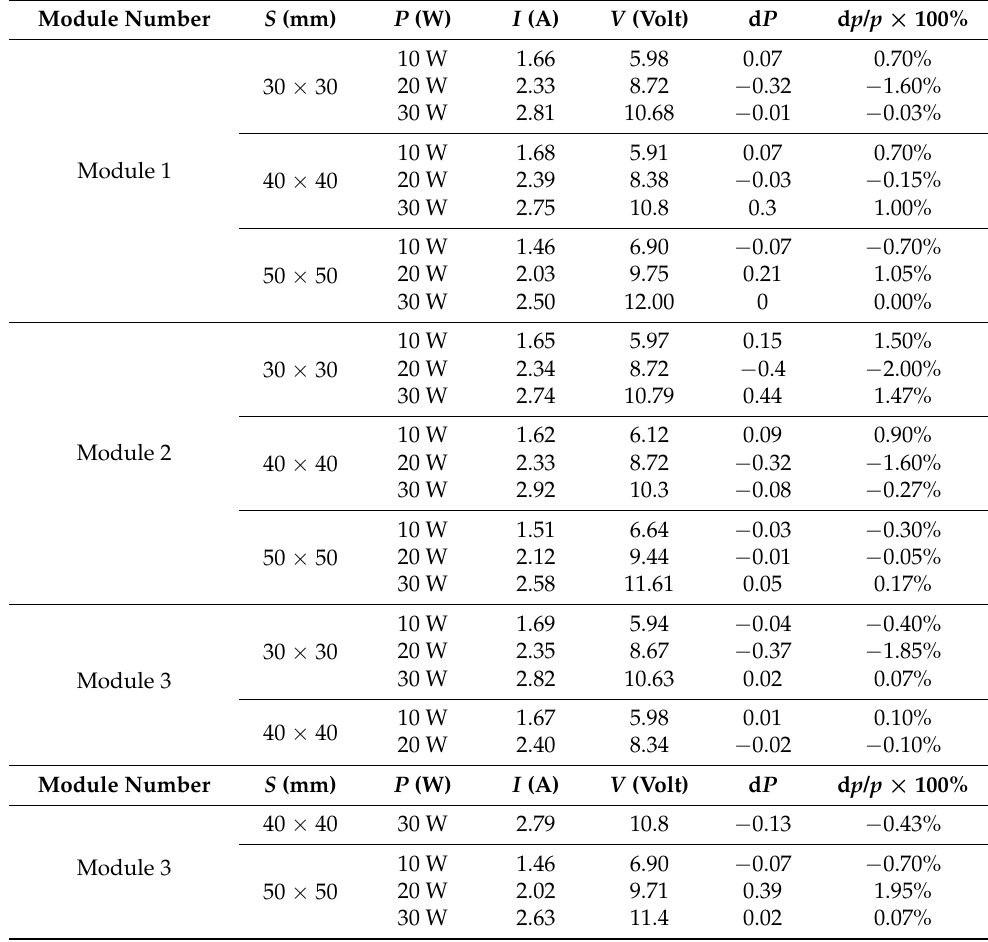
Table 3. Uncertainty of input